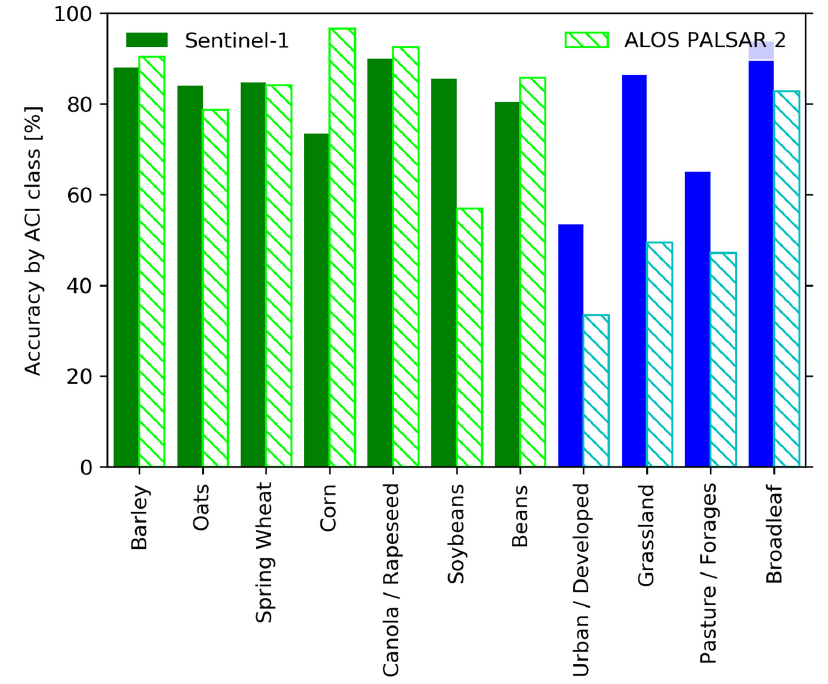
Figure 8. Bar graph showing the overall accuracy by ACI land cover class with prevalence >2% for the Sentinel-1 (solid bars) and PALSAR-2 (hatched bars) data. the Sentinel-1 (solid bars) and PALSAR-2 (hatched bars)